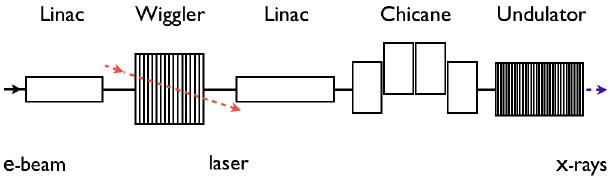
FIG. 1. ESASE schematics; adapted